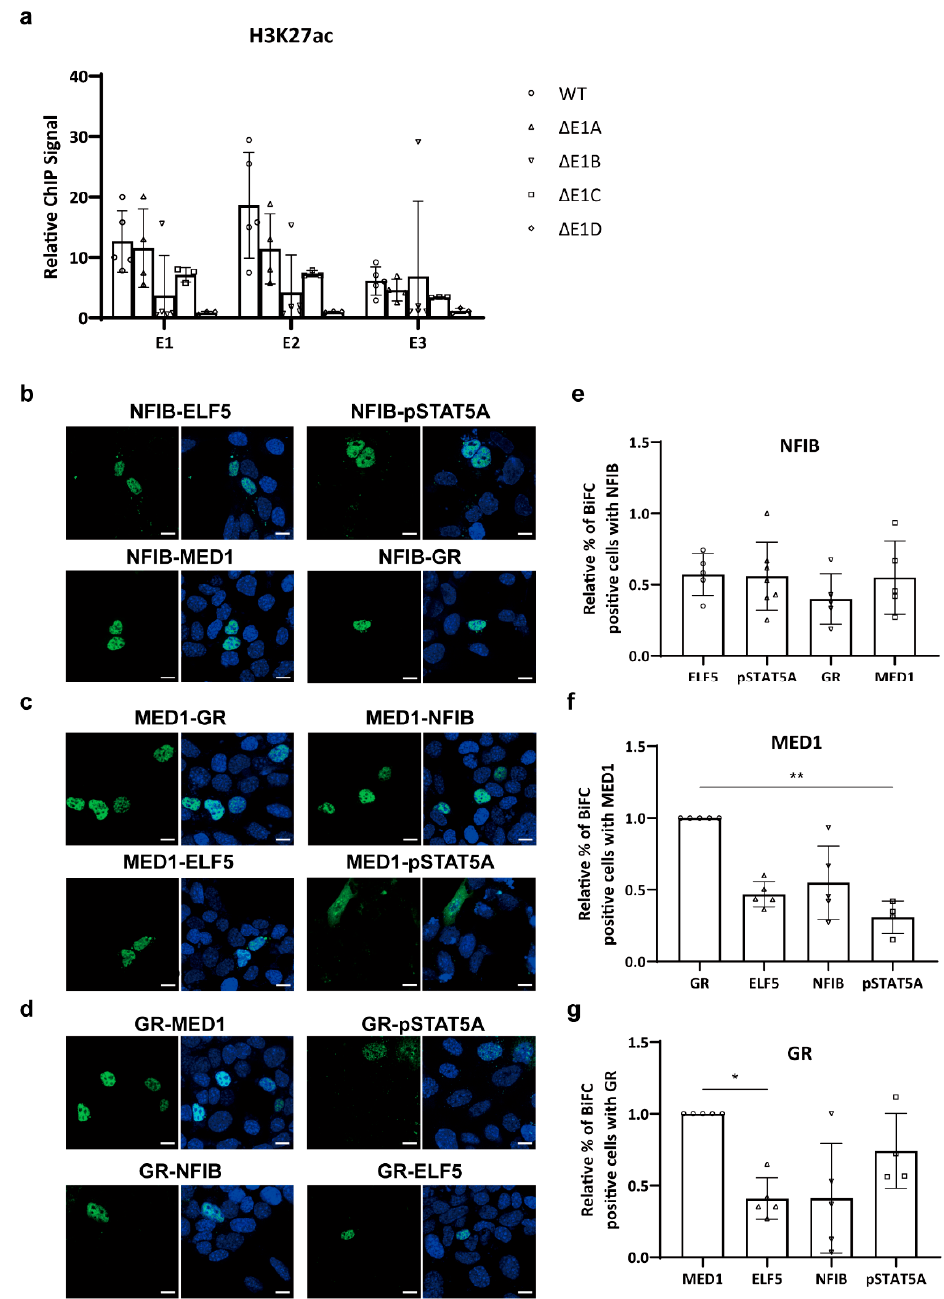
Figure 5. Chromatin features of E1, E2, and E3 constituent enhancers within the mammary-specific Wap super-enhancer. ( a ) ChIP analyses of the active enhancer mark, H3K27ac, in E1-mutant mice. Relative ChIP signals are shown. WT, n = 5; ∆ E1A, n = 4; ∆ E1B, n = 5; ∆ E1C, n = 3; ∆ E1D, n = 3. ChIPed DNA levels were normalized to corresponding input DNA levels. ( b – d ) Molecular interac- tions between mammary-enriched transcription factors in HC11 cells, detected by BiFC analyses. BiFC signals are shown in green, and cell nuclei are shown in blue. Magnification, 800 × ; scale bar, 10 µ M. Representative images from five independent experiments are shown. ( e – g ) Relative percentages of BiFC-positive cells. The number of BiFC-positive cells was normalized to that of DAPI-stained cells in three different fields per slide from five independent experiments (* p < 0.05; ** p < 0.01).